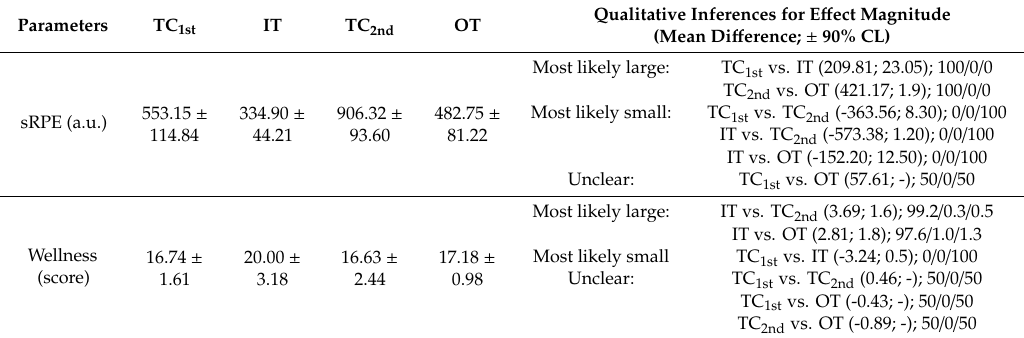
Table 4. The qualitative probabilities of daily session rating of perceived exertion and general wellness score in first training camp, invitation tournament, second training camp, and o ffi cial tournament. Parameters TC 1st IT TC 2nd